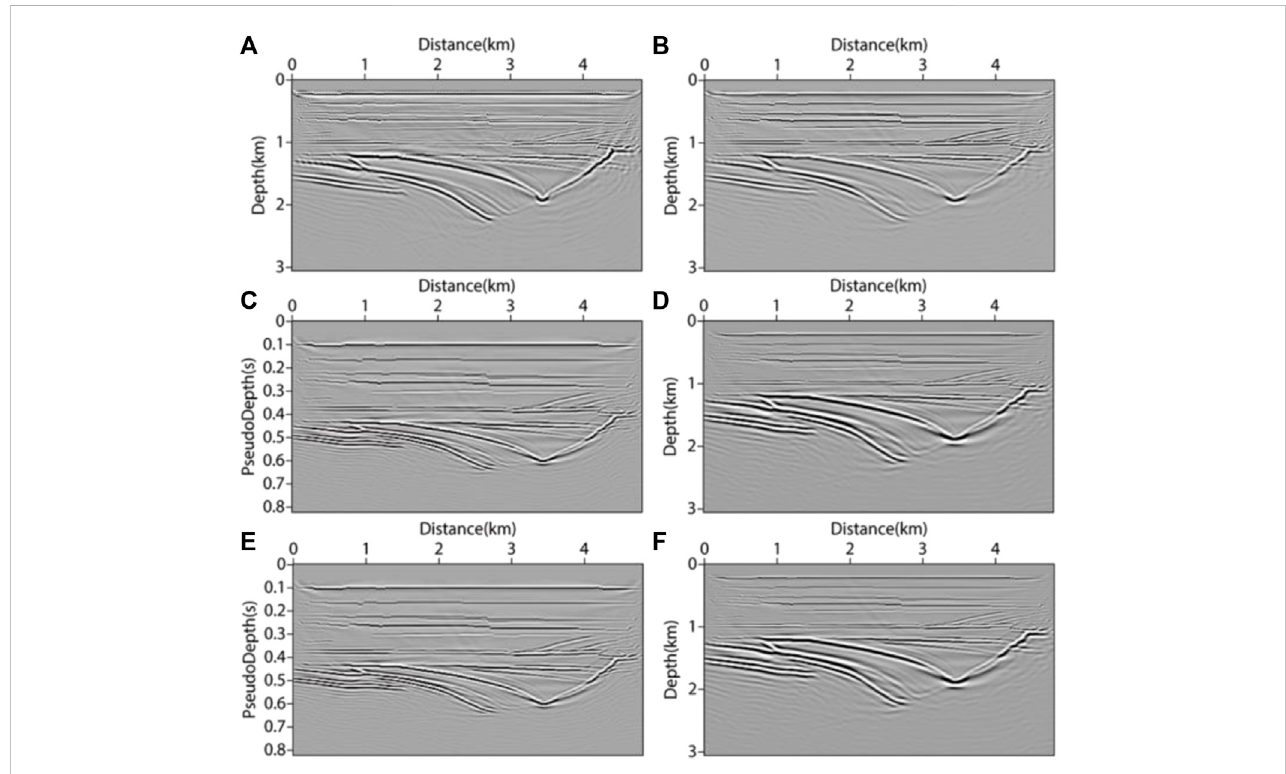
FIGURE 10 Migration results of SL model. (A) acoustic isotropy RTM method; (B) x -direction imaging results of VTI-RTM method in depth domain; (C) x -direction imagingresultsofVTI-PDRTMmethod; (D) inversetransform (C) to x -directionimagingresultsindepthdomain; (E) z -directionimagingresultsofVTI-PDRTM method; (F) inverse transform (E) to z -direction imaging results in depth